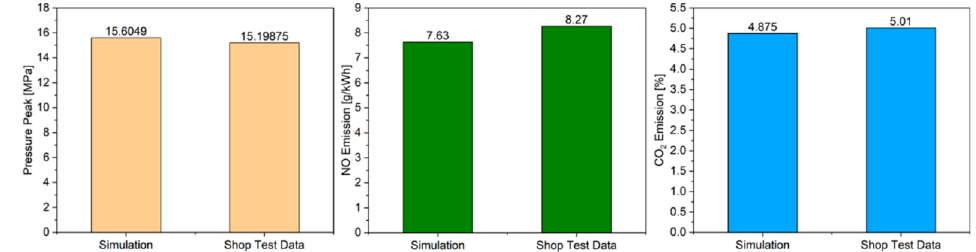
Figure 7. Comparisons of simulation results and shop test